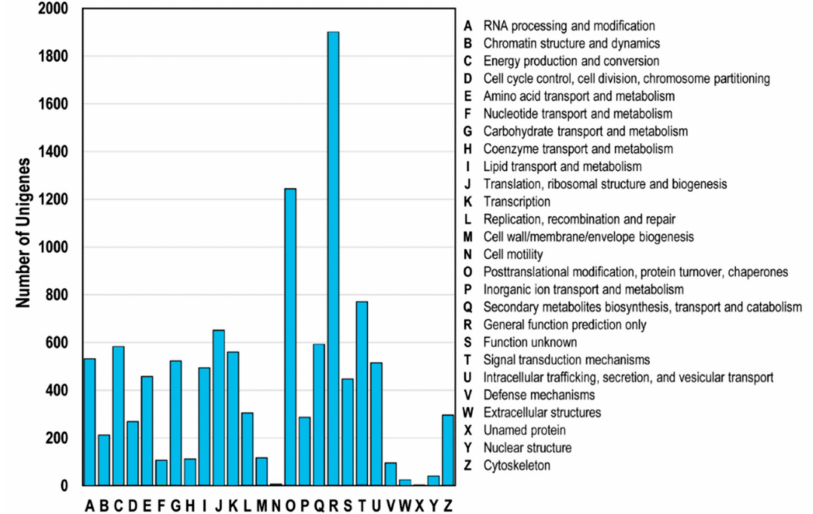
Figure 4. Clusters of orthologous groups (COG) classification. A total of 4044 unigenes with NCBI non-redundant protein (Nr) hits were grouped into 26 COG terms. The y-axis represents the the number of